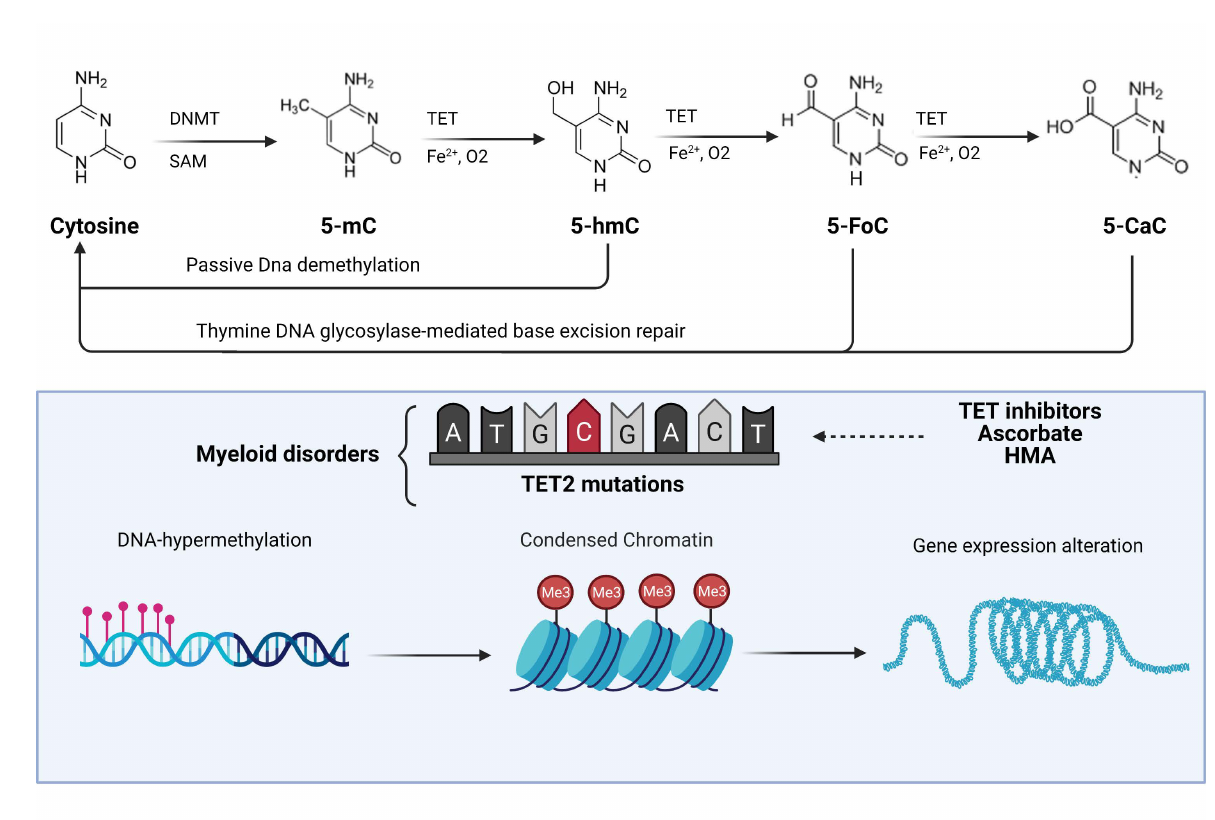
Figure 2. TET functions and their alterations in myeloid malignancies. DNA methyltransferases (DNMTs) initiate cytosine methylation with conversion to 5-methylcytosine (5-mc). TET proteins progressively oxidize 5-mC to 5- hydroxymethylcytosine (5-hmC), 5-formylcytosine (5-FoC), and 5-carboxylcytosine (5-CaC) creating a pool of TET-oxidized products (TDOP). 5-hmC can be reverted to cytosine via passive dilution while 5-FoC and 5-CaC via thymine DNA glycosylase-mediated base excision repair. Somatic TET2 mutations create an imbalance in cellular DNA methylation through the disruption of the aforementioned mechanism with alteration of chromatin and thereby consequences on expression of genes regulating cell division and self-renewal. Images were generated using